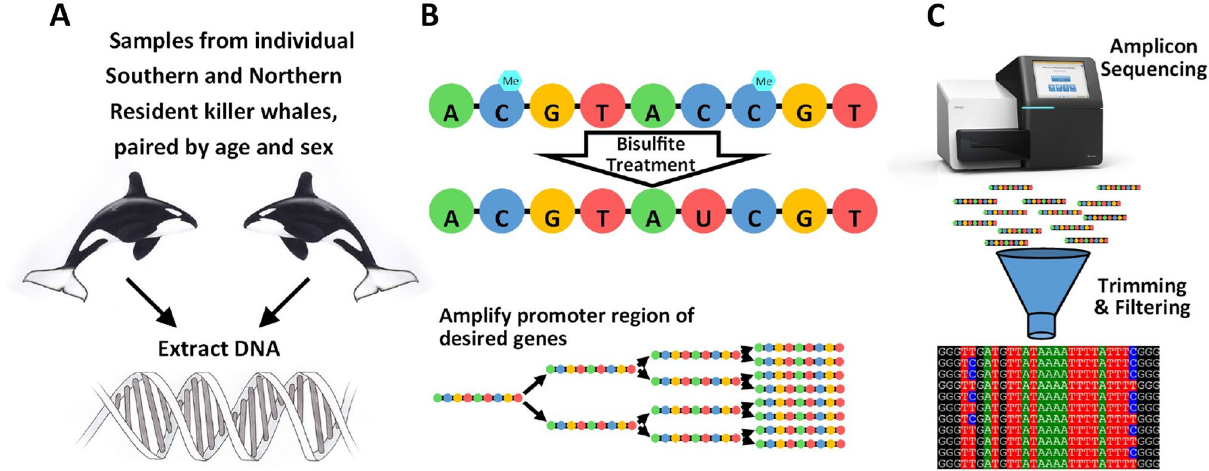
Figure 1. Summary of methods to generate percent of methylation at each CpG site. (A) Biopsy samples were collected from Northern and Southern Resident killer whales and DNA was extracted. (B) DNA